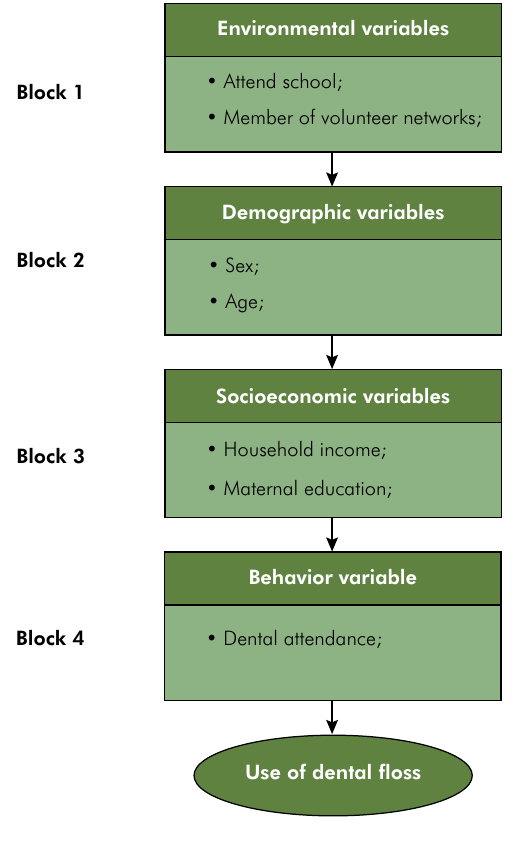
Figure. Theoretical framework for the multiple hierarchical model.